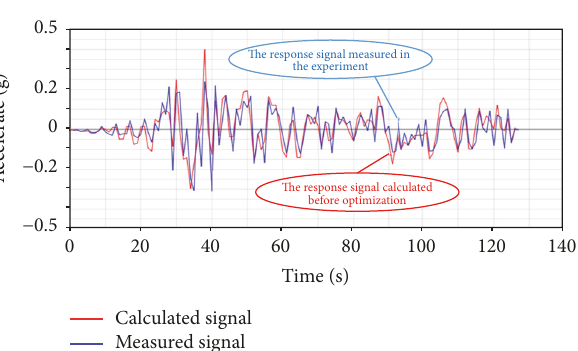
Figure 7: The convergent curve of the objective